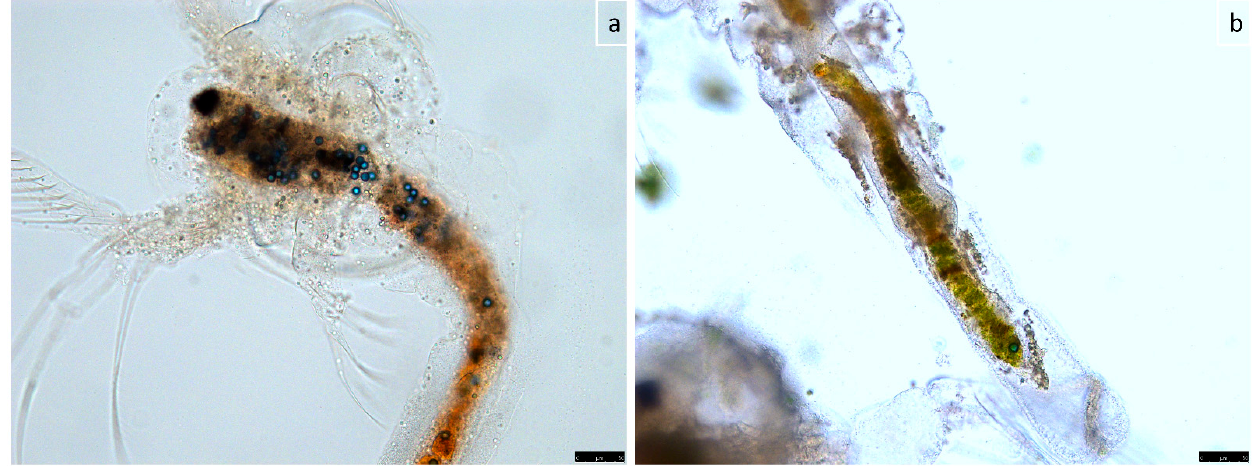
Figure 9. 10 µm Polybead ® Blue Dyed Microspheres detected in dead specimens. ( a ) Group B specimen; ( b ) Group A specimen. Scale bars: 50 µm.